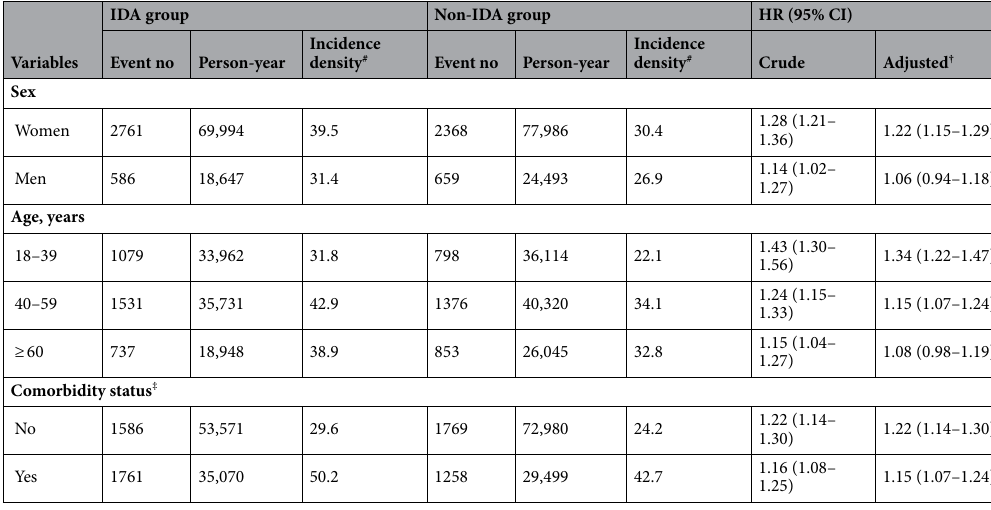
Table 3. Incidence density and hazard ratios of fibromyalgia according to iron deficiency anemia status stratified by sex, age, and comorbidity. IDA iron deficiency anemia, HR hazard ratio, CI confidence interval. # Per 1000 person-years. † Model mutually adjusted for sex, age, and each comorbidity (including diabetes, obesity, osteoarthrosis, sleep disorder, irritable bowel syndrome, migraine, TMJ, depression, and anxiety). ‡ Patients with any one of diabetes, obesity, osteoarthrosis, sleep disorder, irritable bowel syndrome, migraine, TMJ, depression, and anxiety were classified as the comorbidity group.